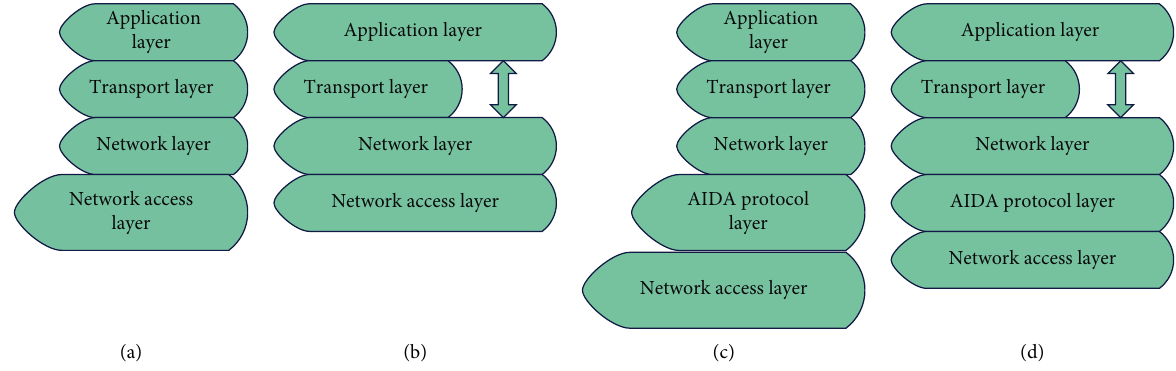
Figure 6: Division of the relationship between data fusion and application layer. (a) DoD. (b) ADDA. (c) AIDA. (d) Comprehensive.